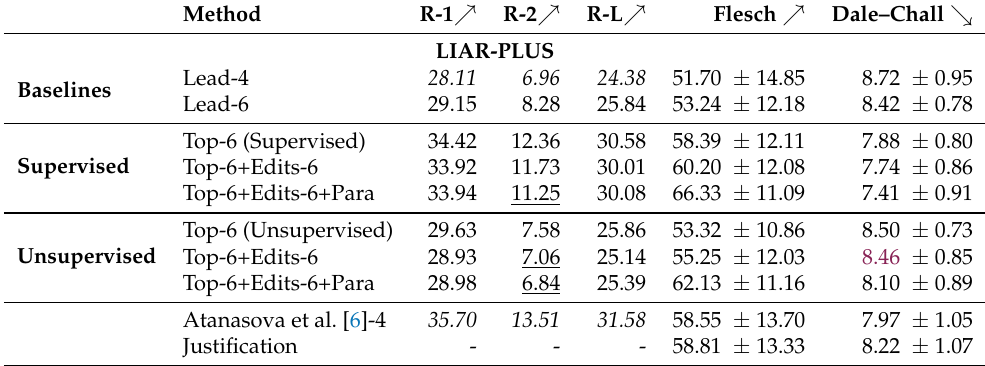
Table 1. ROUGE-1/2/L F1 scores (see Section 5.1), and readability measures (see Section 5.2) over the test splits (for validation and ablations, see the Table A3 in appendix). Readability measures include sample variance. In italics , we report results reported from prior work, where we do not always have the outputs to compute readability. Underlined ROUGE scores of the Top-N+Edits-N and Top- N+Edits-N+Para are statistically significant ( p < 0.05) compared to the input Top-N ROUGE scores, N = {5, 6}. Readability scores for Top-N+Edits-N and Top-N+Edits-N+Para are statistically significant ( p < 0.05) compared to Top-N, and to Atanasova et al. [6]-3/4, except for the score in